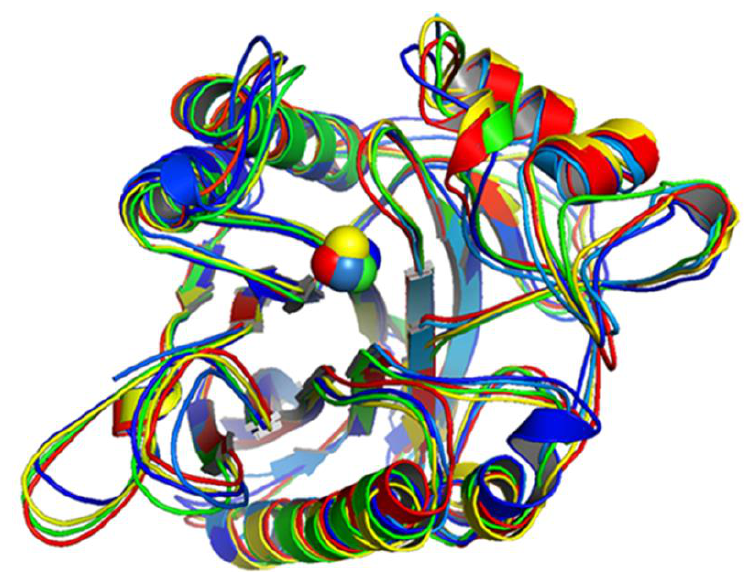
Figure 2. Superposed nSMase2 structures. Superposed crystal 5UVG and MD-derived structures after 10 ns (dark blue), 20 ns (light blue), 30 ns (neon green), 40 ns (spring green), 50 ns (light green), 60 ns (yellow), 70 ns (dark yellow), 80 ns (light orange), 90 ns (orange), 100 ns (red), 5UVG (sky blue).